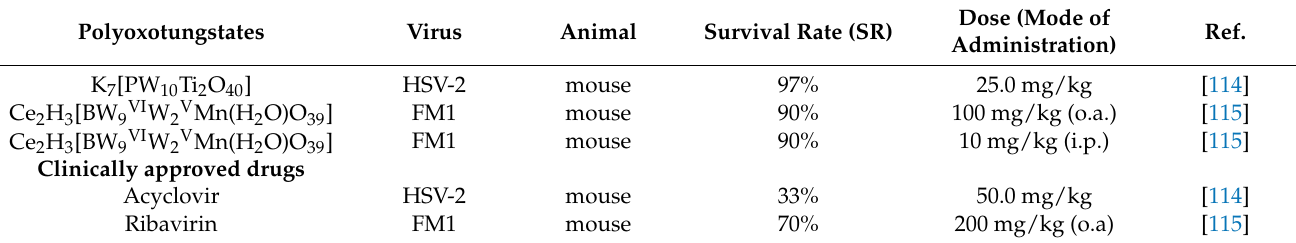
Table 2. In vivo antiviral activity of